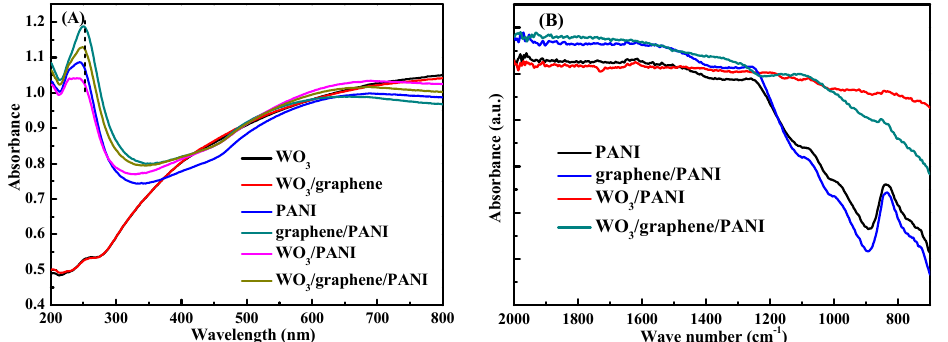
Figure 2. ( A ) UV-vis and ( B ) FT-IR spectra of bare WO 3 film, double layer WO 3 / graphene film, pristine PANI film, double layer graphene / PANI film, double layer WO 3 / PANI film, and triple layer WO 3 / graphene / PANI film, respectively.